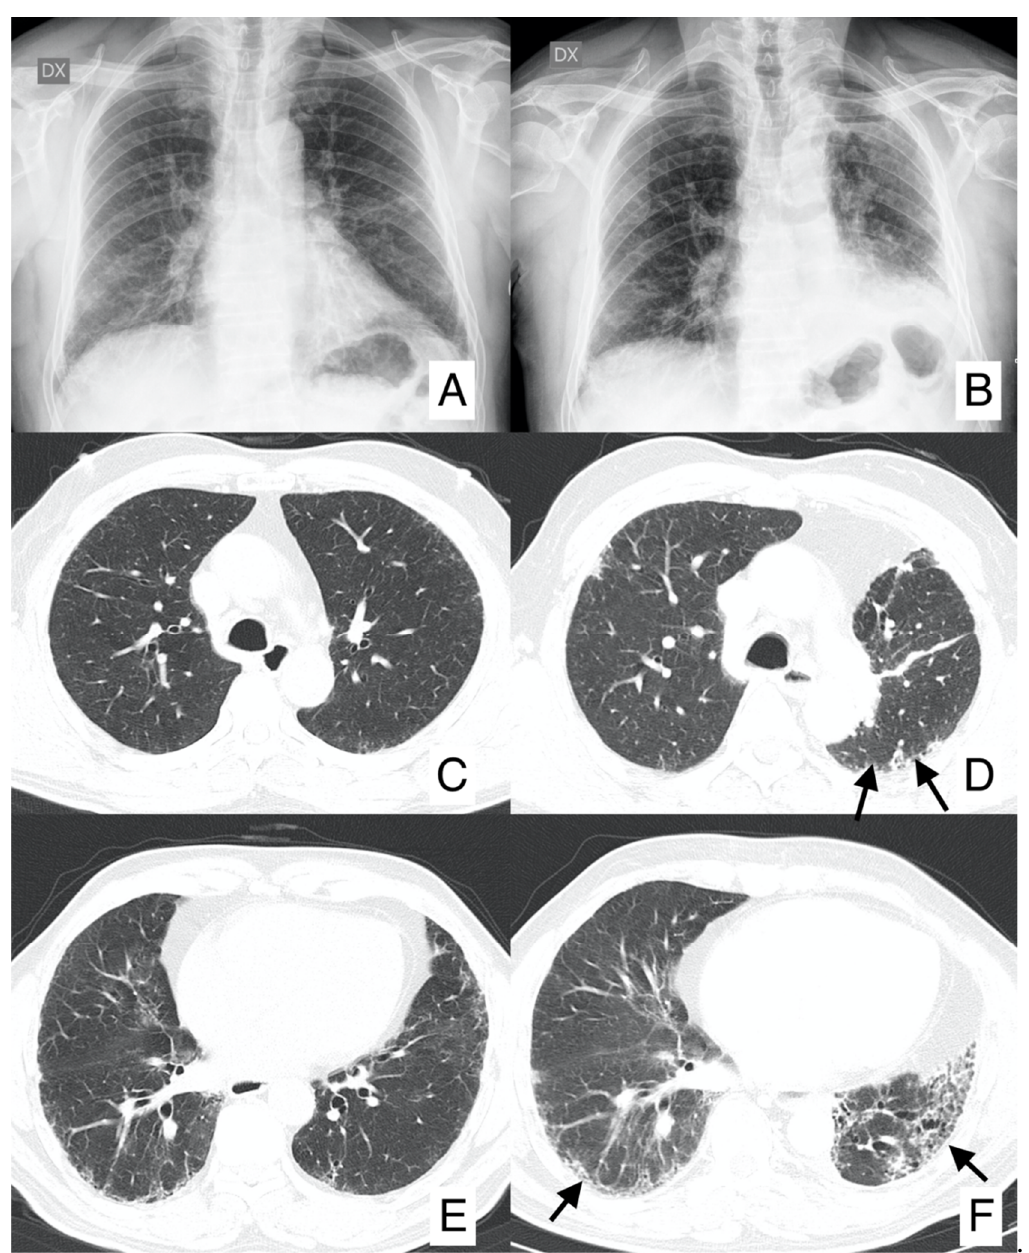
Figure 4. Progression of IPF disease after surgical resection of nodular neoplastic lesion (same patient as Figure 3, having IPF complicated by squamous cell carcinoma). Chest radiographs ( A , B ) acquired before and after surgical resection: it is possible to appreciate the increased reticular pattern (namely in the left lung). Axial CT images before ( C , E ) and after surgery ( D , F ). CT images clearly show progression of reticulations—well-depicted in subpleural regions (black arrows).